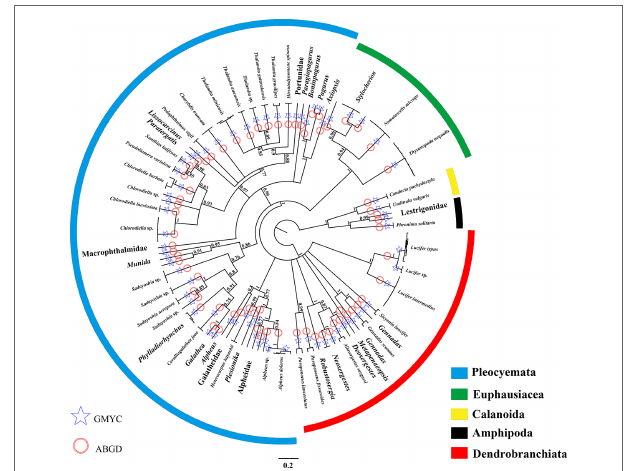
FIGURE 2 | Phylogenetic tree obtained through Bayesian inference of the COI dataset for marine crustacean larvae present at the Zhongsha Islands, using MrBayes, with the scale bars proportional to substitution rates. Bayesian posterior probabilities are shown on the branches (values below 0.7 are not shown). DNA identifications through the molecular approaches (Generalized Mixed Yule Coalescent model [GMYC] and Automatic Barcode Gap Discovery analysis [ABGD]) are shown on the branches. The major clades are depicted by different colors to reflect groups of species in the same